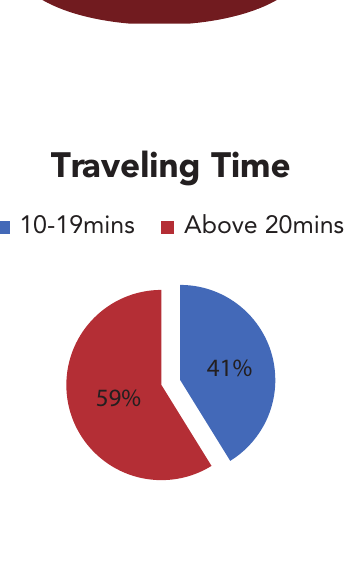
Figure 1: Operating